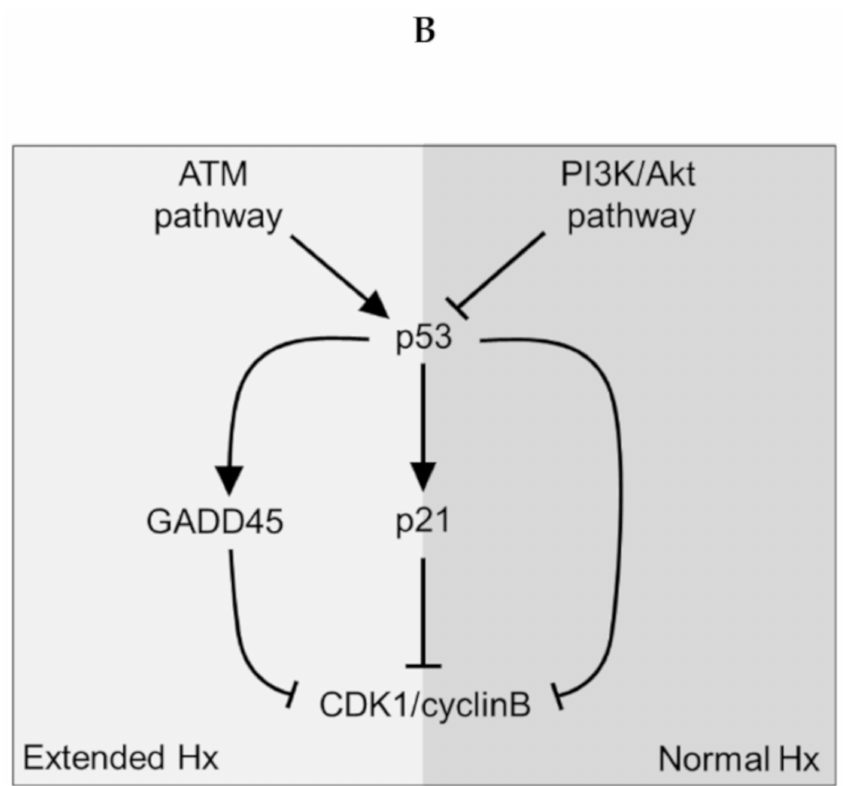
Figure 4. IPA functional analysis on the set mRNAs targeted by the recognized miRNAs. ( A ) Plotted PAS values for miRNA-a ff ected ISPs after nHx (black) and eHx (red). ( B ) Schematic presentation how the ATM- and the PI3K / Akt Signaling Pathway are integrated at the molecular level. After nHx, p53 is inhibited by the PI3K / Akt Signaling Pathway resulting in lower expression of the cell cycle inhibitor p21, so that the cell cycle block (CDK1 / cyclin B) is released and proliferation is induced. Overstimulation of the ATM Signaling Pathway bypasses the PI3K / Akt pathway to further activate the p53-p21 axis 48 h after eHx only (see Table 3). Hence, the ATM Signaling Pathway induces an additional eHx-specific proliferation block via GADD45, the inhibitor of CDK1 / cyclinB. Arrows: stimulation; Blunt arrows: